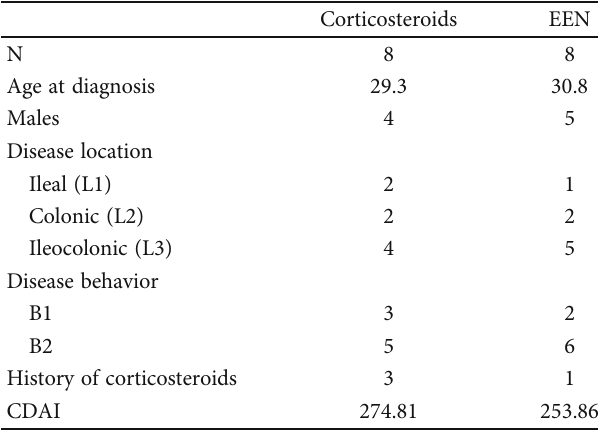
Table 1: Baseline characteristics of the study